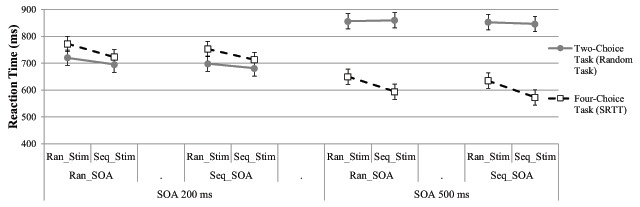
Mean RTs with timing sequence, stimulus sequence and SOA factors for the two-choice task and the four-choice task (SRTT) in Experiment 2 plotted with 95% within subjects confidence intervals based on the error variance of timing sequence × stimulus sequence (Masson & Loftus, 2003). The exact values can be found in Appendix Table A4.